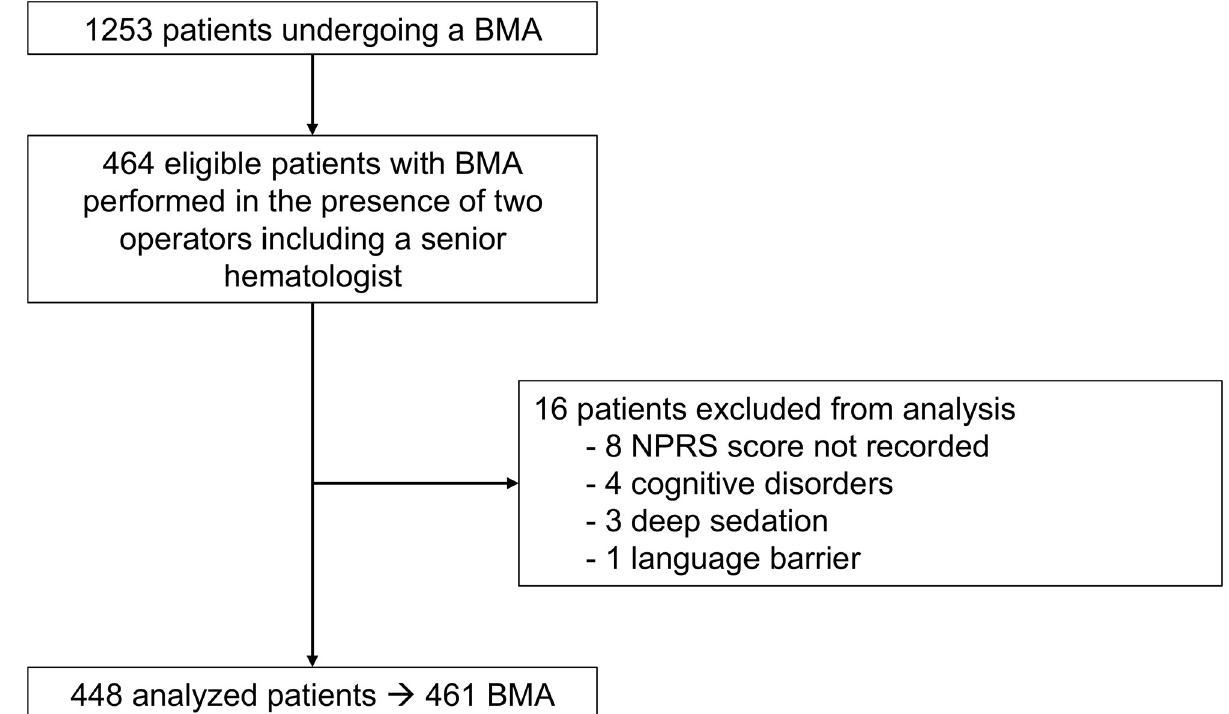
Fig 2. Patient flowchart. BMA: bone marrow aspiration; NPRS: numerical pain rating scale score.